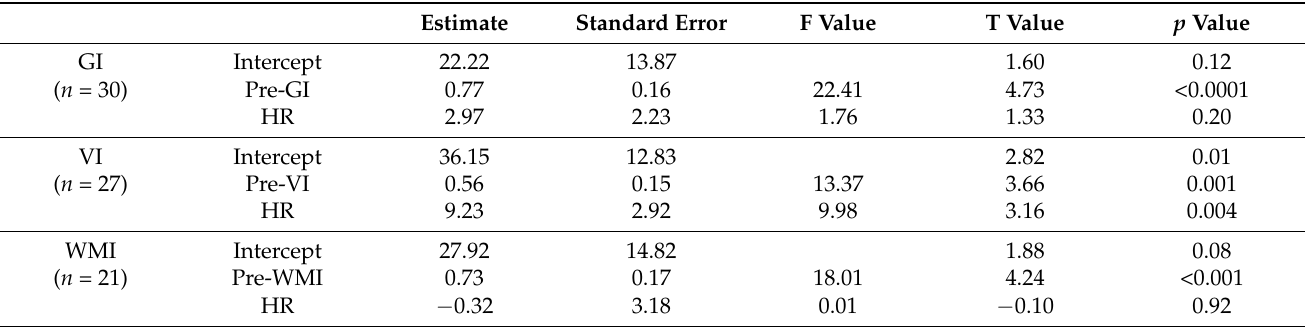
Table 4. Analysis of covariance for the effect of hippocampal resection on postoperative cognitive index.